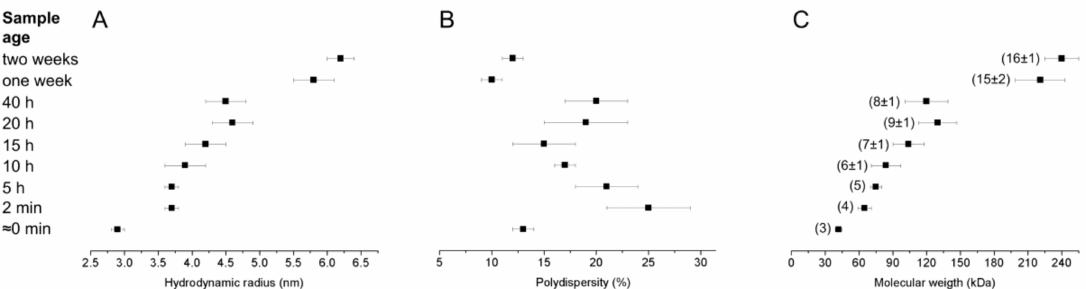
Figure 5. DLS measurements of a filtered Id2’ solution in pure water (80 µ M) over a period of two weeks at 21 ◦ C. The hydrodynamic radius ( A ), polydispersity ( B ), and molecular weight ( C ) corresponding to each sample age represent the averaged value of 7–10 acquisitions. The number of self-associated Id2’ monomers is reported in the brackets in panel